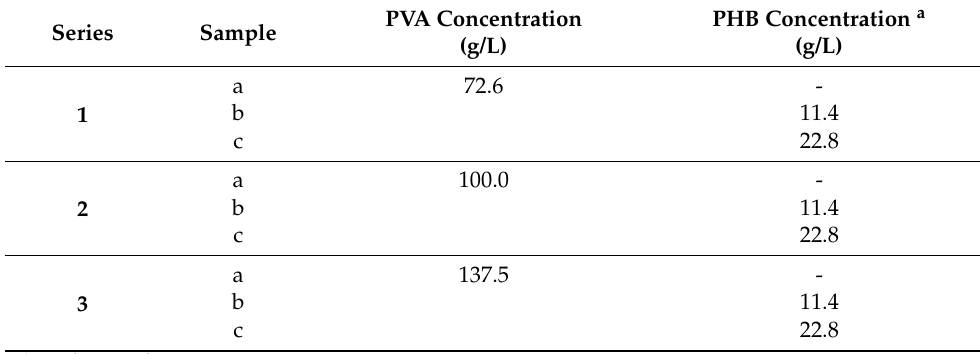
Table 1. Composition of the feed solutions and suspensions further used for the preparation of non-filled and composite PVA cryogels.